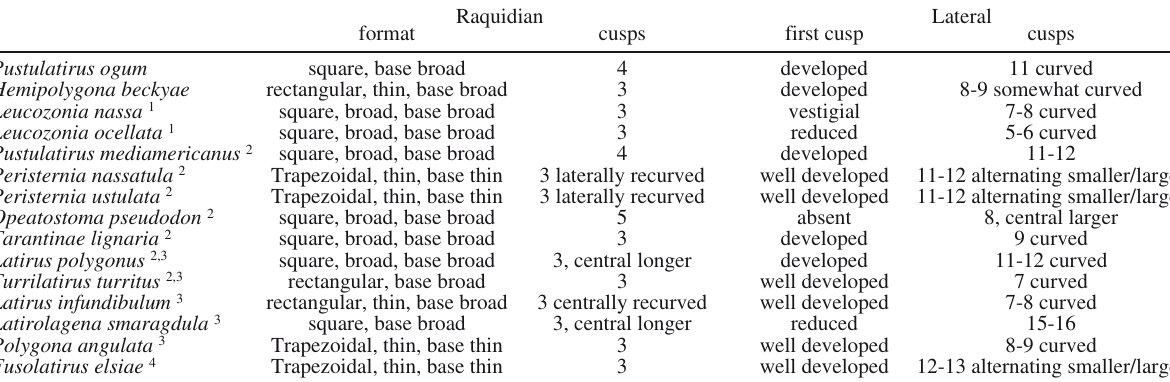
Table 1. – Main comparative radular features of the Peristerniinae based on our data and those of 1 Couto and Pimenta (2012), 2 Kosyan et al. (2009), 3 Bandel (1984) and 4 Snyder and Bouchet